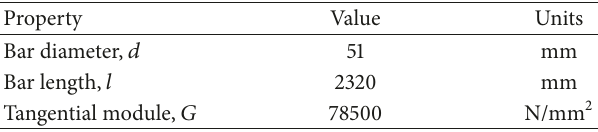
Table 5: Properties of the antiroll bar.